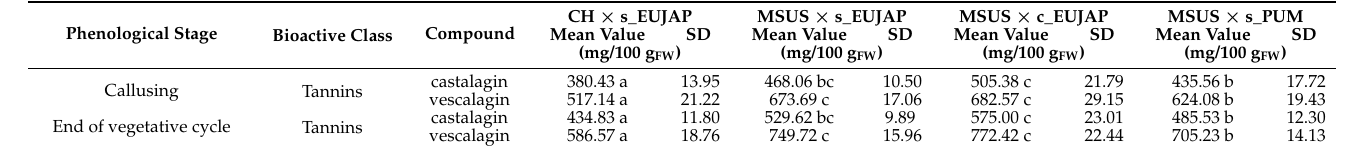
Table 5. Tannin fingerprint of the tissues at the graft union. The results are reported as mg of bioactive compound per 100 g fresh weight